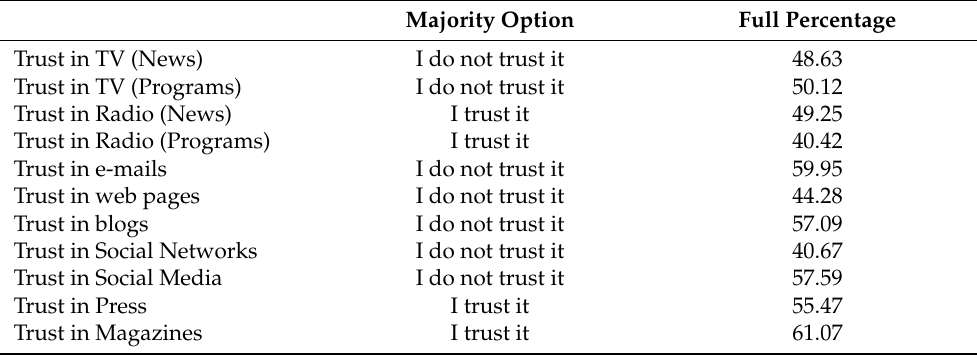
Table 2. Confidence in the media of university students from Nuevo Le ó n, Valle de M é xico and Oaxaca.